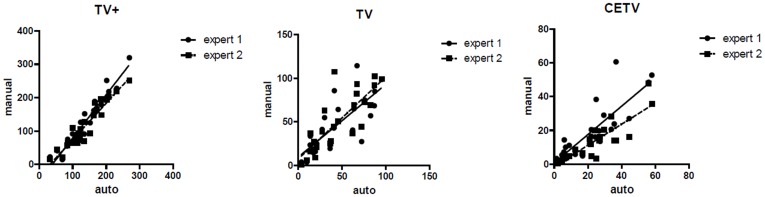
Scatter plot of the absolute volume measurement for TV+, TV and CETV (from left to right).Volumes measured automatically are shown on the x-axis, volumes measured manually by the two expert raters are shown on the y-axis.